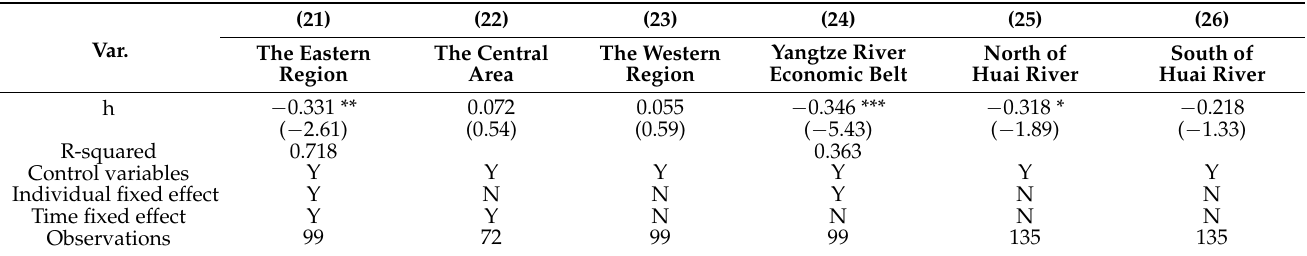
Table 6. Estimated results of heterogeneous